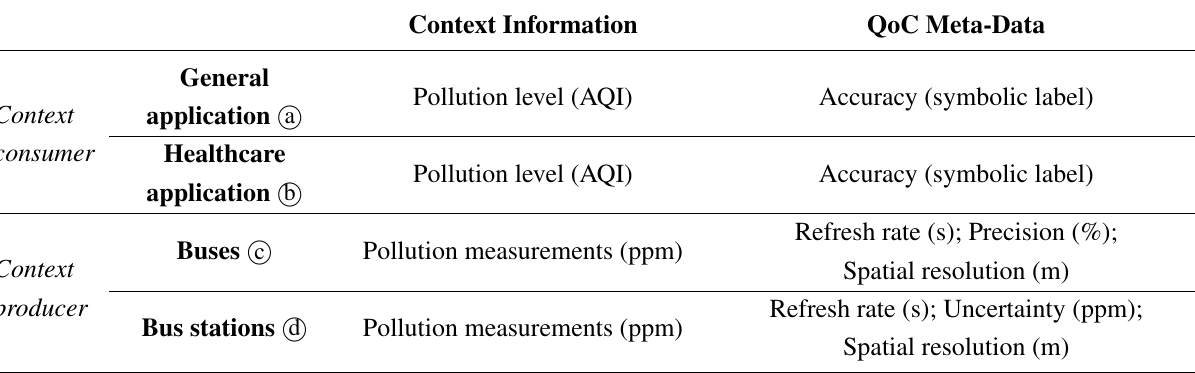
Table 1. Abstract of the context information and QoC meta-data used in the